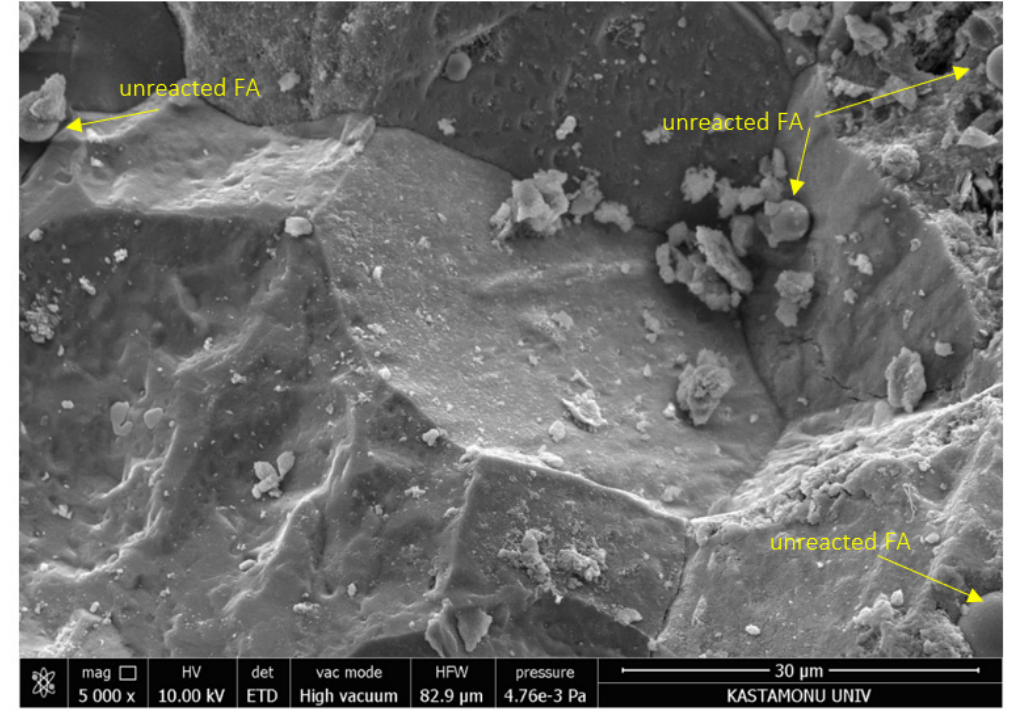
Figure 16. SEM of the 1 NCa sample magnified at 5000 times.